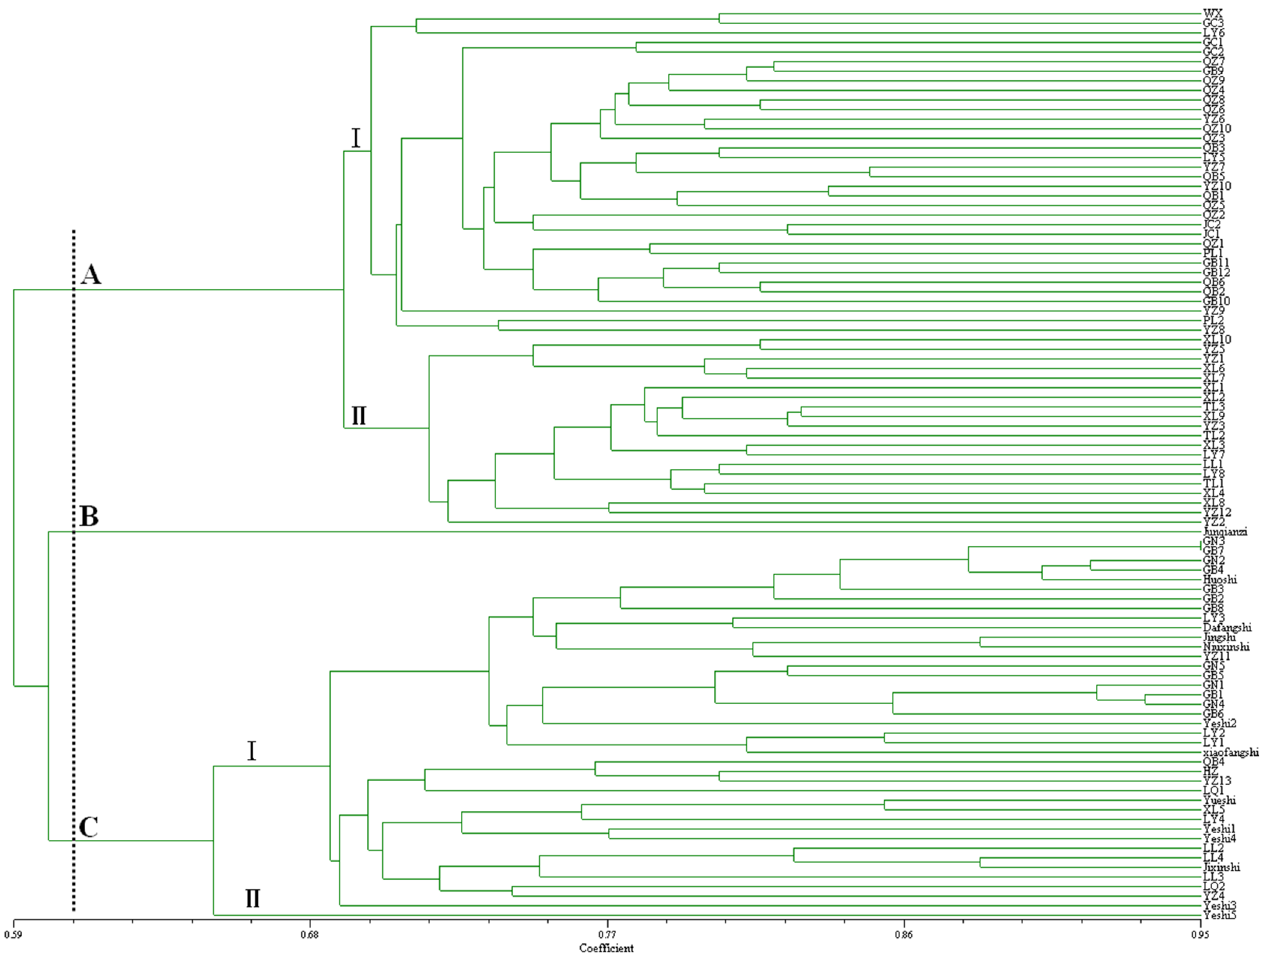
Fig 2. UPGMA dendrogram of the accessions of 95 diospyros germplasms based on SCoT molecular markers.